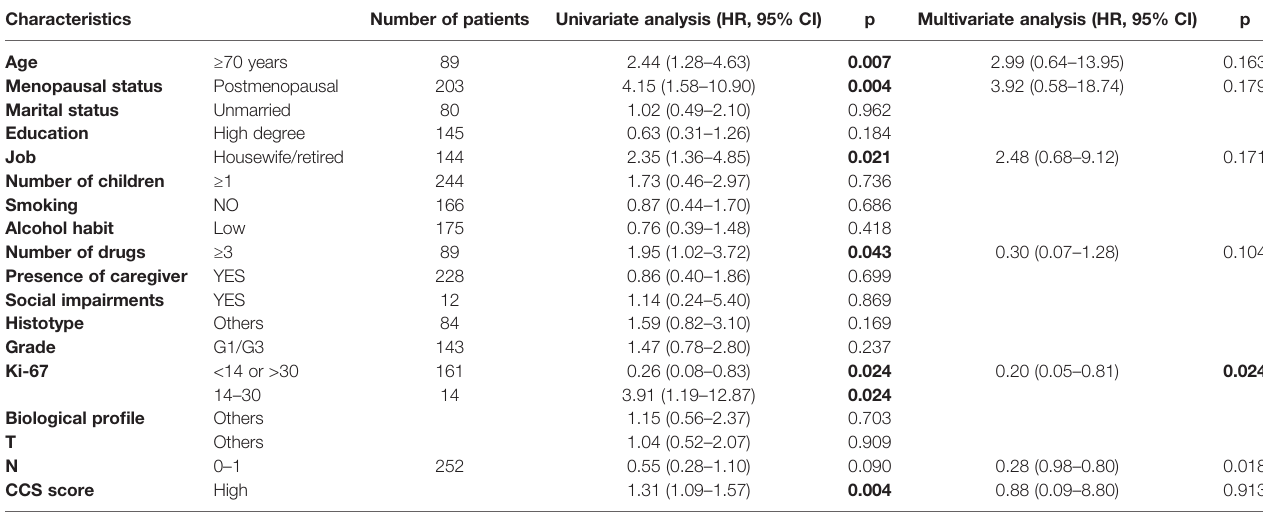
TABLE 2 | Factors associated with discordance through univariate and multivariate